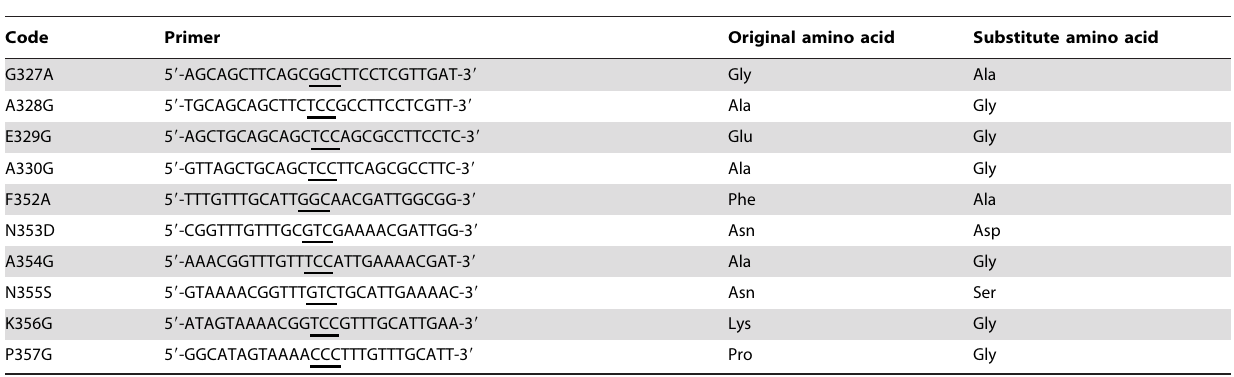
Table 1. Primers of site-directed mutagenesis.